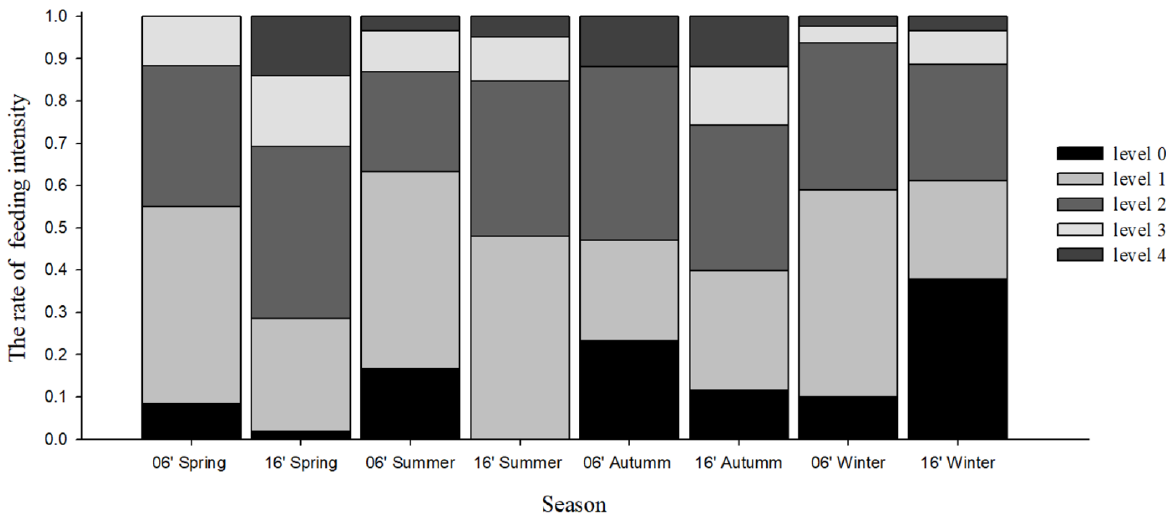
Figure 3. Seasonal proportions of feeding intensity of Johnius belengerii during the periods of 2006– 2007 and